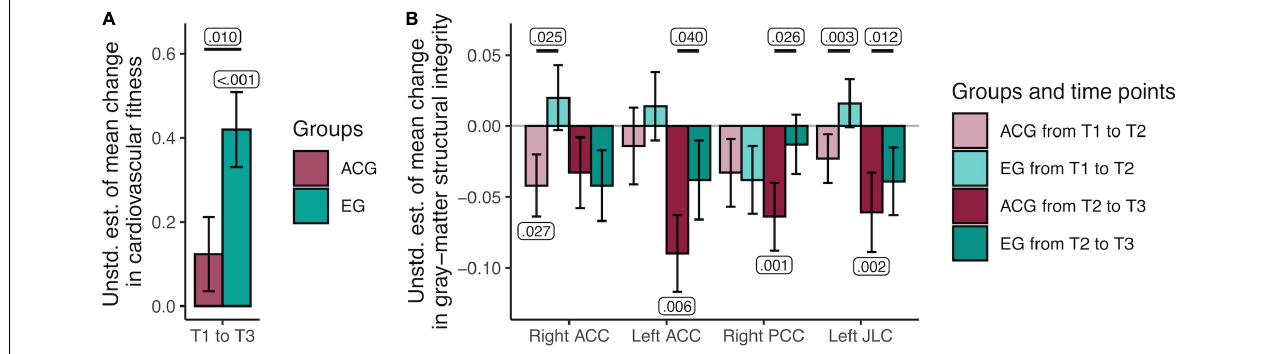
FIGURE 4 | Unstandardized parameter estimates of mean changes in cardiovascular fitness and gray-matter structural integrity by group. (A) Results of the univariate latent change score model (LCSM) of VO 2 peak indicated that the active control group showed no mean changes in fitness, whereas the exercise group showed a significant mean increase in fitness over time. (B) Results of the multivariate LCSM of gray-matter structural integrity indicated that the active control group showed significant mean decreases in latent gray-matter structural integrity over time in the left and right anterior cingulate cortex, right posterior cingulate cortex, and left juxtapositional lobule cortex (previously supplementary motor area), while the exercise group exhibited maintenance in integrity in these regions. Unstd. est., unstandardized estimate; T1, time point 1 (0 months); T2, time point 2 (3 months); T3, time point 3 (6 months); ACG, active control group; EG, exercise group. Significant p -values of one-sided t -tests of individual parameters against zero (negative in ACG and positive in EG) as well as differences in group mean change are displayed. Error bars represent estimated